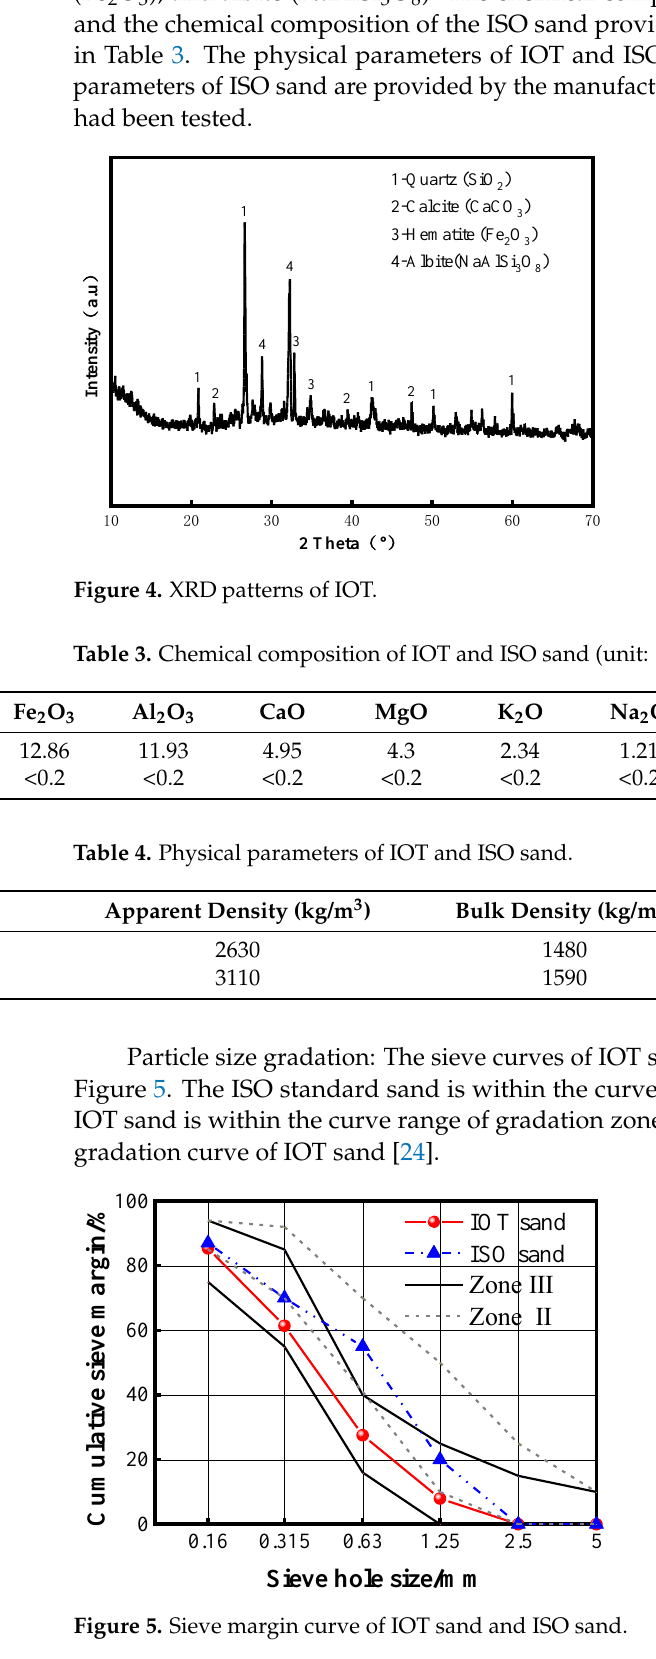
Figure 6. Particle size curve of IOT sand. Combined with the above results, the fineness modulus μ f of the IOT sand is 1.81, similar to the fine sand used in construction sand. Thus, it can be used as a fine aggregate to replace a portion of the ISO standard sand as a construction material. 3.2. Mechanical Tests 3.2.1. Mechanical Tests Analysis All mechanical tests were performed on a microcomputer-controlled electronic uni- versal testing machine, in which the uniaxial tensile test was loaded with a displacement control of 0.2 mm/min; the SCB three-point bending test was loaded with a displacement of 0.05 mm/min, and the uniaxial compression test was loaded with a load control of 0.3 MPa/s. The load and loading curves of the specimens at fracture were recorded, and the corresponding tensile and compressive strengths and ultimate fracture loads were calcu- lated. Figure 7a – c shows the mechanical test results of each test specimen, and Figure 7d shows the comparison of the compressive strength at 28d with the results obtained by other authors.